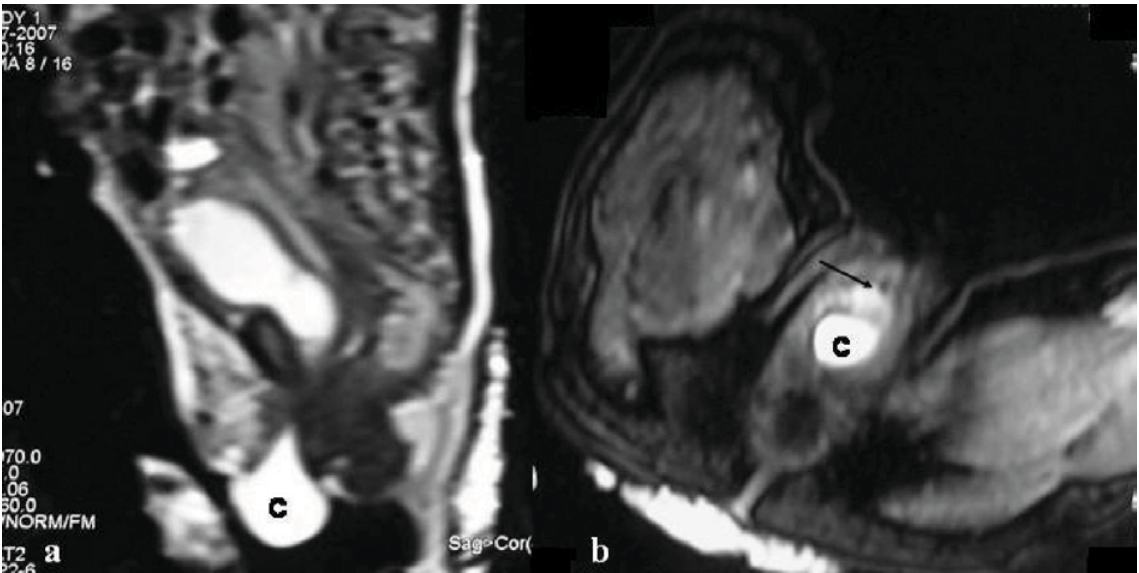
Figure 3. T2-weighted MRI examination. a) The part of the cyst extending to the pelvic area is clearly seen in the sagittal image. b) The position of the cyst posterior to the urethra is shown in the axial image C: Cyst; Black arrow: